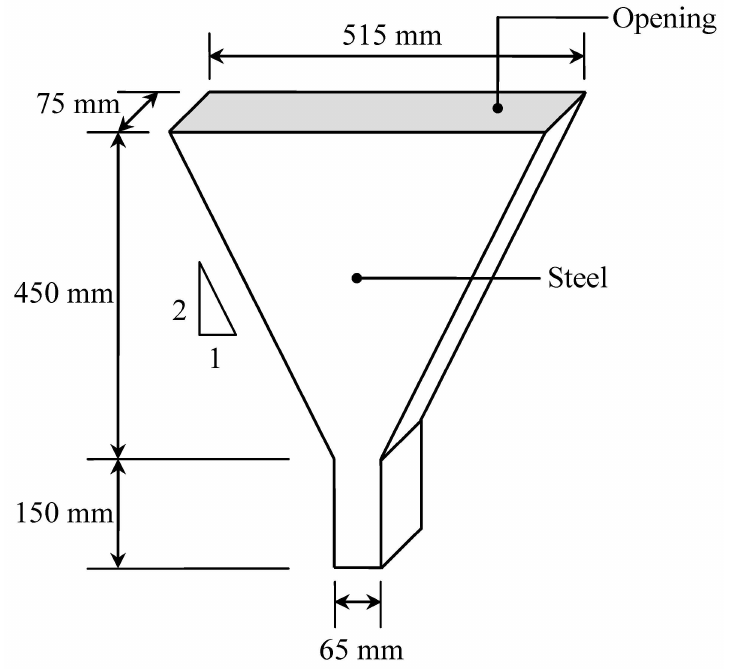
Figure 1. V-funnel